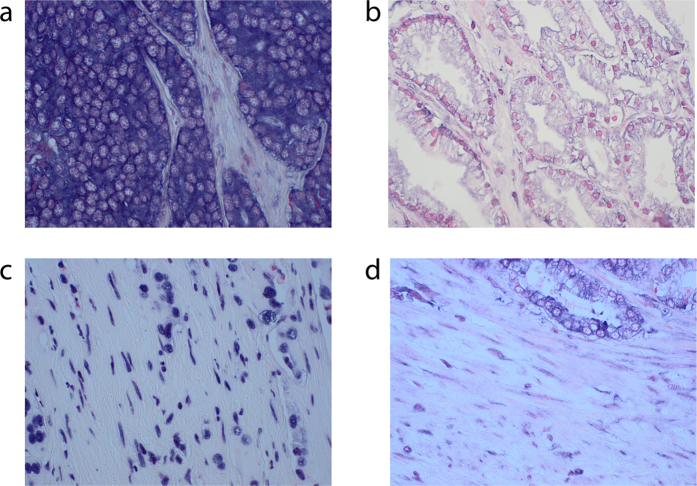
400× microscope pictures of (a) high tumor cell miR-210 expression, (b) Low tumor cell miR-210 expression, (c) high fibroblast miR-210 expression, (d) low fibroblast miR-210 expression.